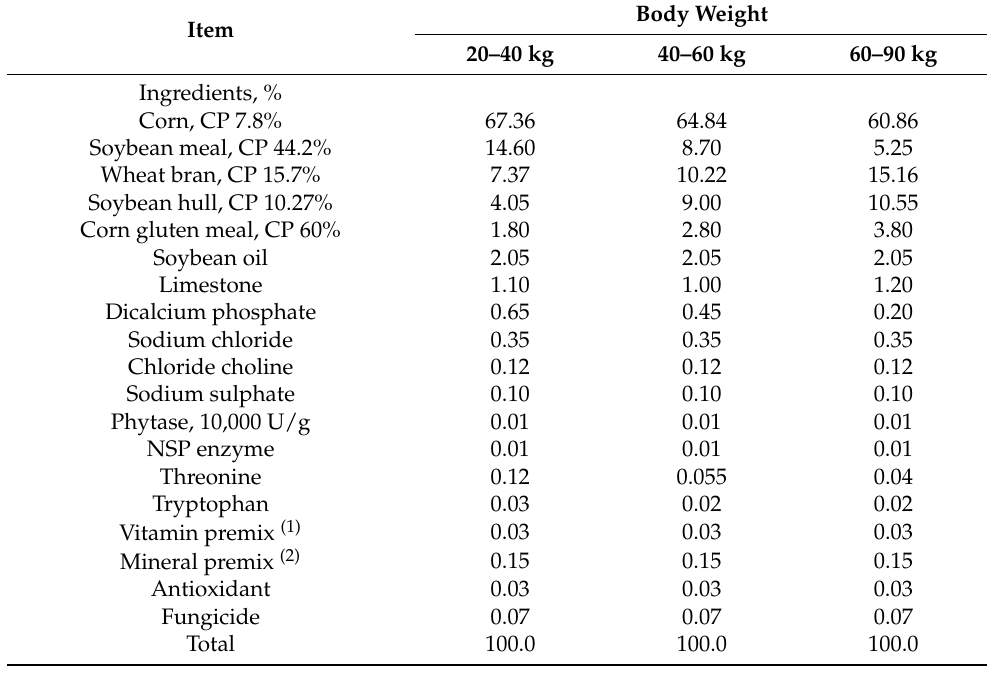
Table 2. Ingredients of basal